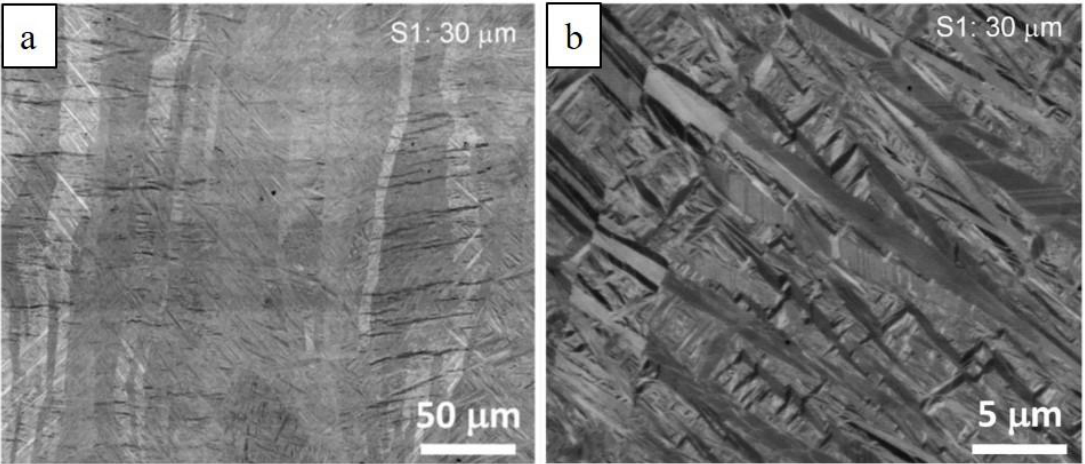
Figure 2. Typical α ’ lath martensite micro structure as processed using SLM method: ( a ) Lower and ( b ) higher magnification [9].